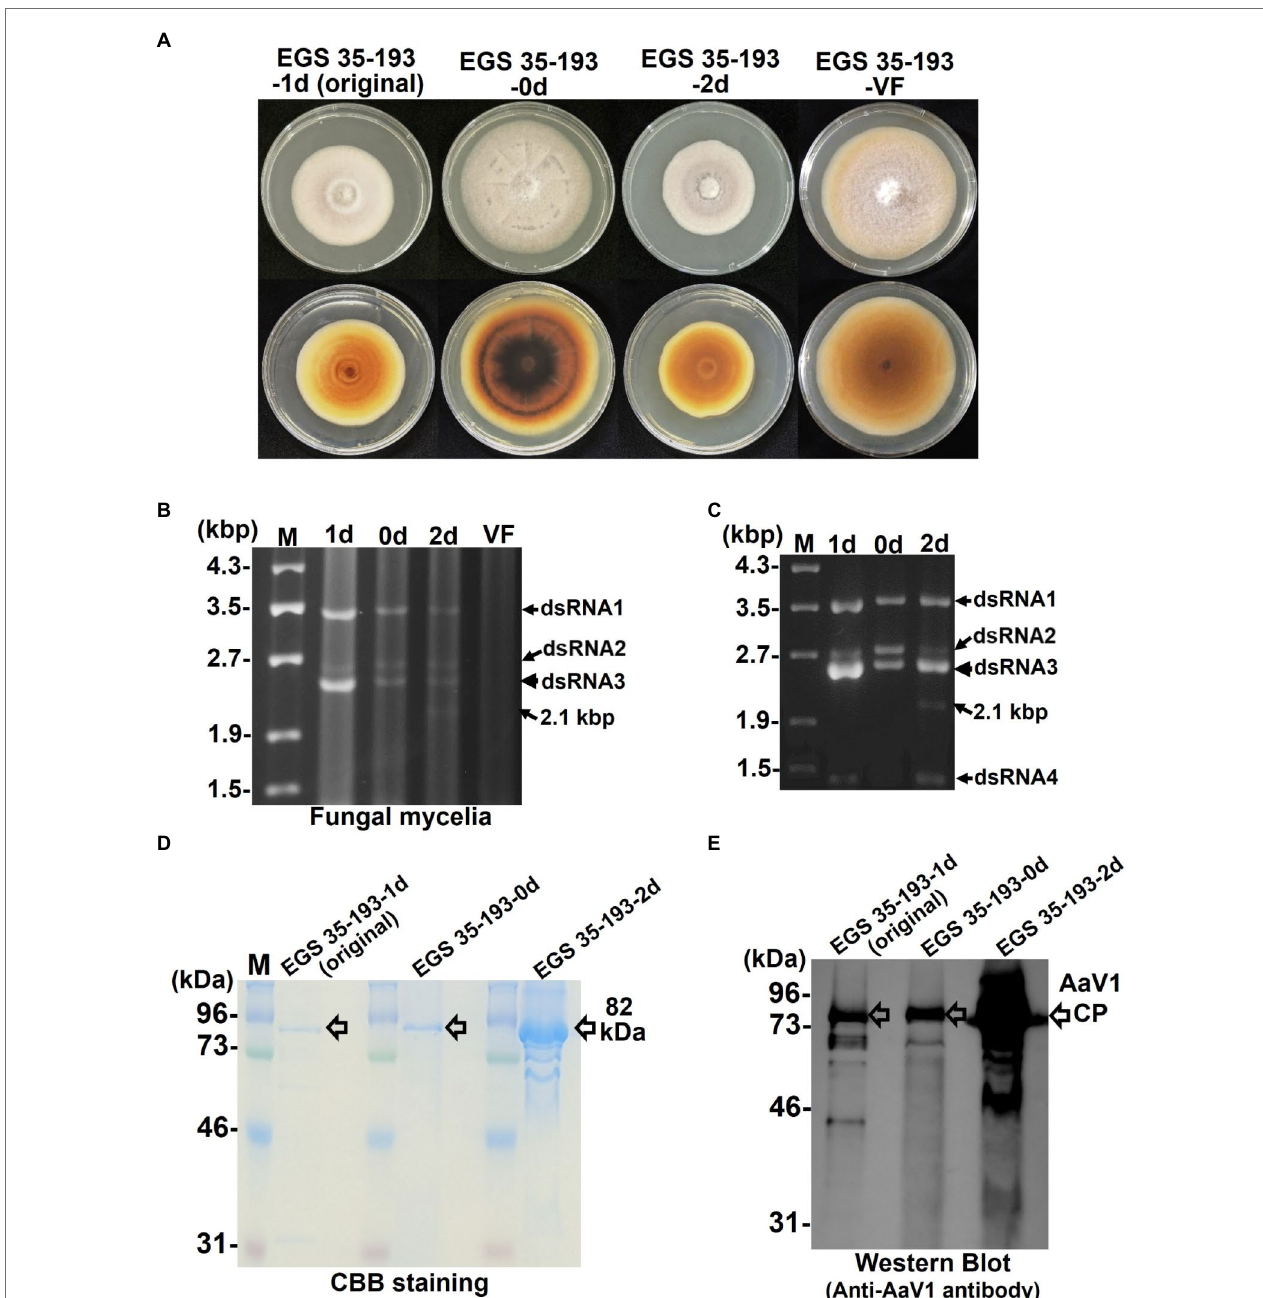
FIGURE 4 | Phenotypic changes in EGS 35–193 mycelia caused by deletions of AaV1 dsRNA2. (A) Four types of colony morphologies were exhibited by the EGS 35–193 derivatives EGS 35–193-1d (the original strain), EGS 35–193-0d, EGS 35–193-2d, and EGS 35-195-VF (AaV1-free), grown on YGA plates for 7 days at 25 ° C. (B, C) Agarose gel electrophoresis of dsRNAs purified from mycelia (20 mg) of the four EGS 35–193 derivatives, purified by the spin column method (B) , and dsRNAs extracted from purified virus particles of the three EGS 35–193 AaV1-infected isolates (C) . The dsRNAs were separated in 1.0% agarose gels with EtBr (0.5 μ g/ml) at 18 V for 20 h. Lane designation: M, 250 ng of λ -EcoT14I-digested DNA marker; 1d, EGS 35–193-1d; 0d, EGS 35–193-0d; 2d, EGS 35–193-2d; VF, EGS 35-193-VF. (D) SDS-PAGE of purified virus particles from EGS 35–193-1d, − 0d, and-2d. The purified viral proteins were separated in an 8% polyacrylamide gel at 120 V for 2 h and then stained with CBB. Lane M, prestained protein marker. (E) Western blot analysis of purified virus particles from EGS 35–193-1d, − 0d, and- 2d, with antiserum raised against the AaV1 virus particles from EGS